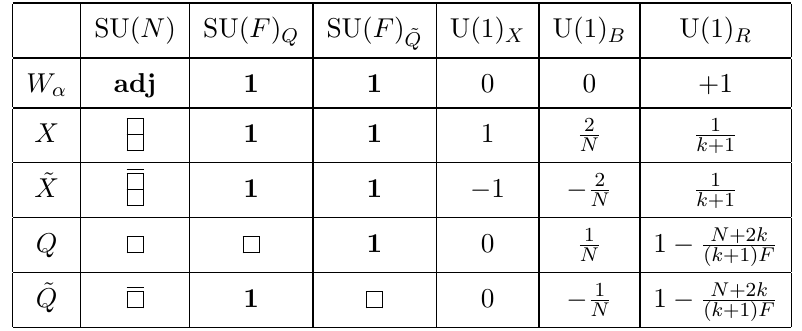
Table 5 . Quantum numbers of fields in the electric SU( N ) SQCD with rank-two anti-symmetric tensors X and ˜ X .